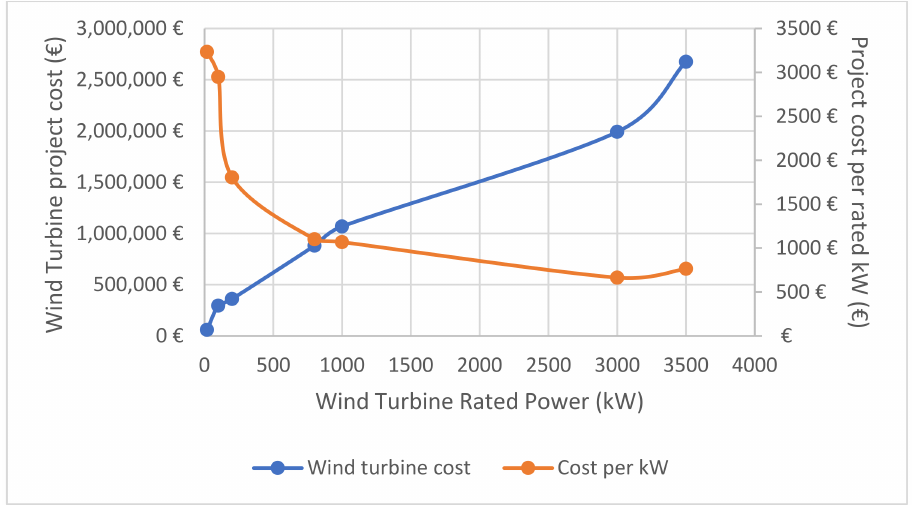
Figure 4. Wind turbine project